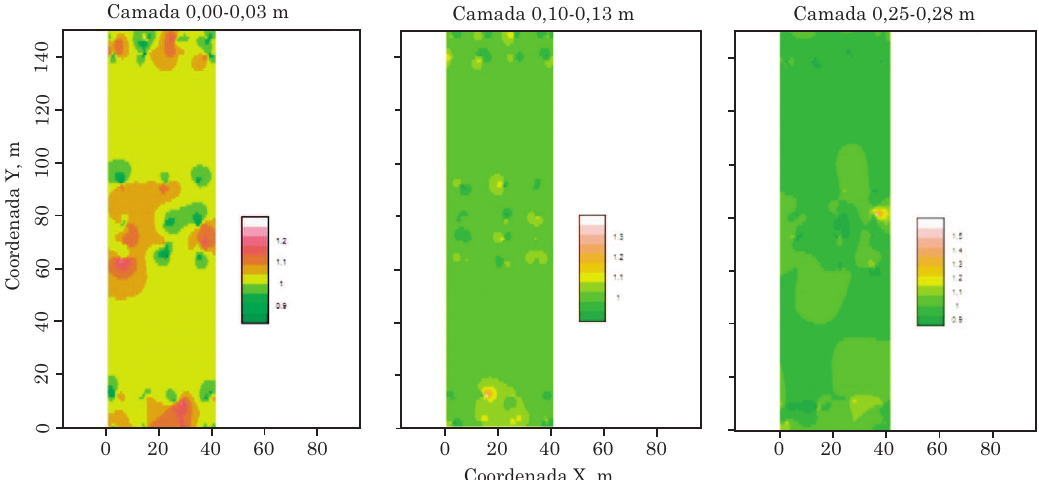
Figura 5. Mapa da distribuição espacial da densidade do solo na área de estudo.